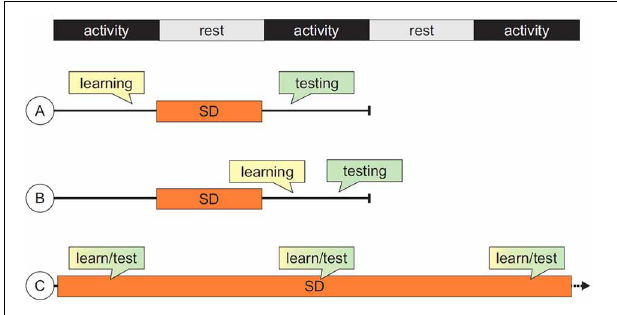
FIGURE 1 | Summary of typical sequences of events in studies of cognitive impairments induced by sleep deprivation (SD). (A) SD follows the acquisition or training phase and precede testing session(s); (B) both training and testing sessions are carried out after the SD epoch; (C) for tasks in which performance can be measured during training itself, sequences of training/SD can be administered repeatedly, allowing the assessment of long-term learning